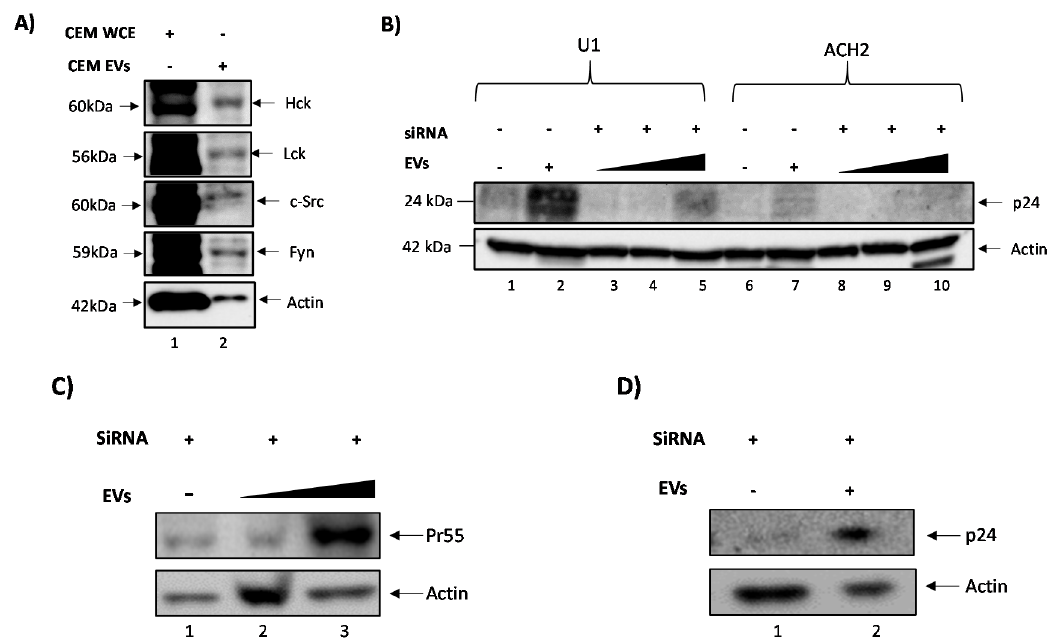
Figure 4. EV-associated c-Src activates HIV-1 in infected cells. ( A ) CEM EVs were isolated via ultracentrifugation (100K) and Western blotted for various src family kinases (lane 2). CEM WCE (lane 1) and actin were used as positive controls. ( B ) Log phase CEM cells were transfected with siRNA (100 nM) against c-Src for 72 h. EVs were isolated using ultracentrifugation (100K), measured, and then added to serum starved (1% FBS) U1 and ACH2 cells at a cell to EV ratio of 1:10 3 , 1:10 4 , or 1:10 5 . Cells were collected 48 h later and Western blotted to assess the levels of newly synthesized